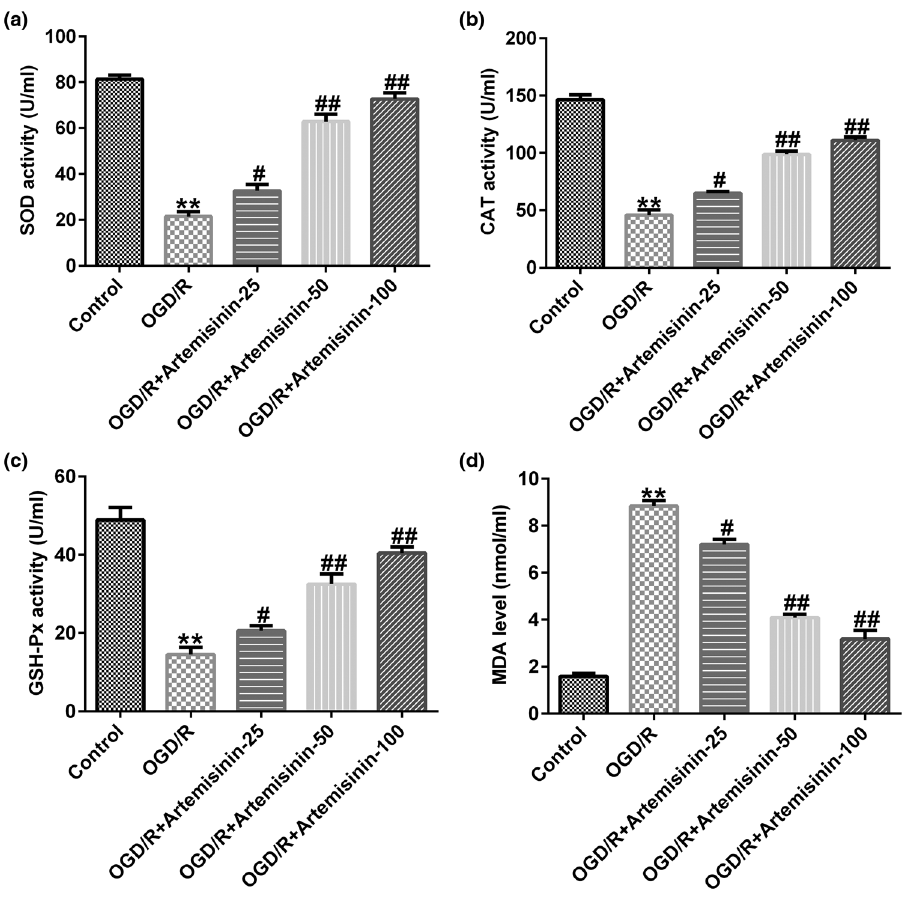
Figure 4: E ff ects of ART on the oxidative stress in OGD/R - induced SH - SY5Y cells. SH - SY5Y cells were pre - treated with the indicated concentrations of ART ( 0, 25, 50, and 100 μ M ) for 2 h and then exposed to OGD/R. Next the activities of SOD ( a ) , CAT ( b ) , and GSH - Px ( c ) and the level of MAD ( d ) were determined. ** p < 0.01 vs Control; #,## p < 0.05, 0.01 vs